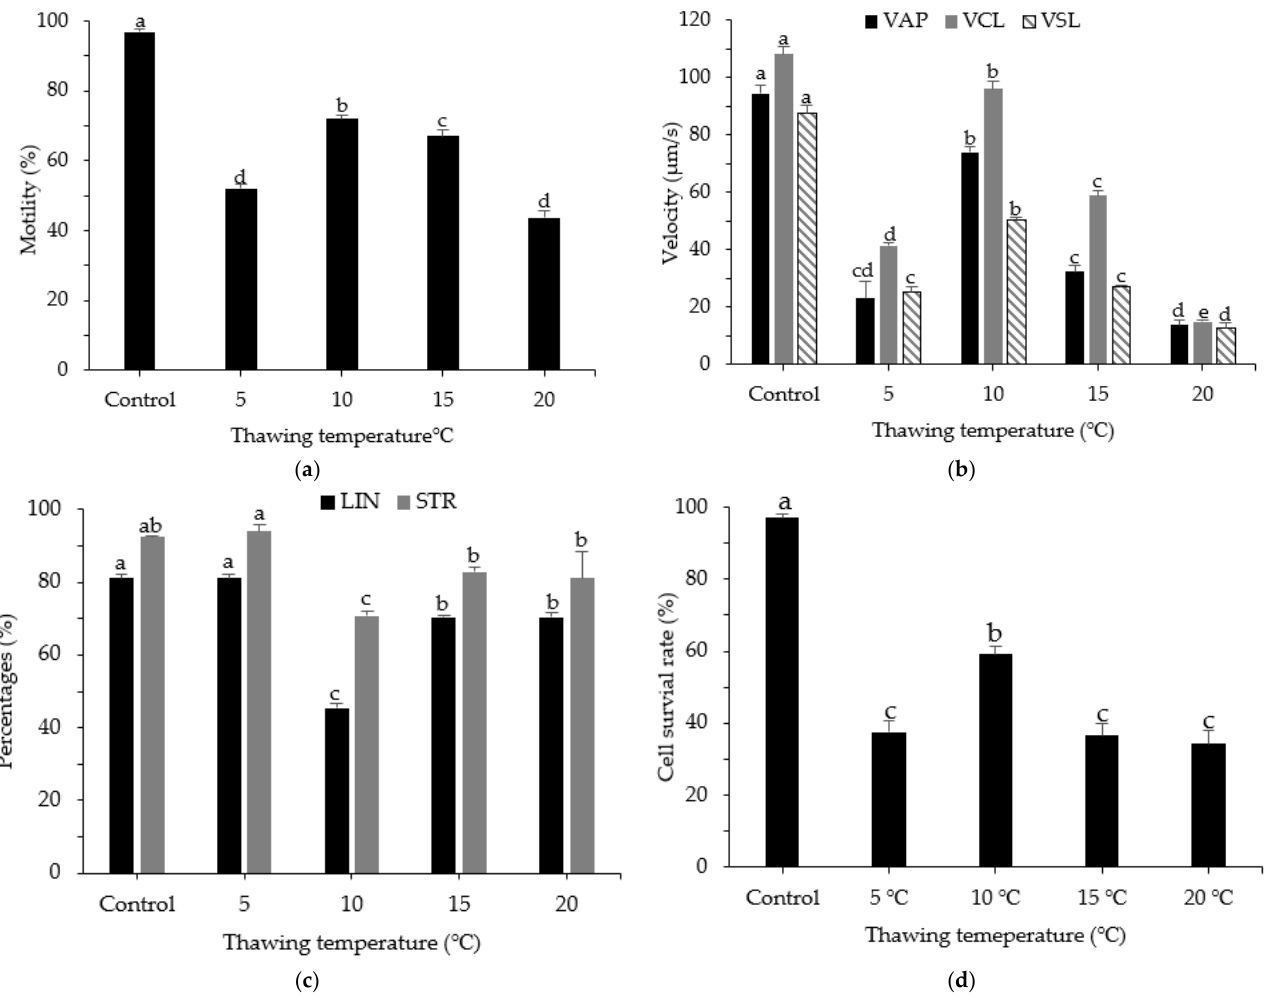
Figure 5. Computer-assisted sperm analysis of frozen and fresh sperm from roughscale sole, Clido- derma asperrimum , using various thawing temperatures. ( a ) Motility (%), ( b ) average path velocity (VAP; μm s −1 ), curvilinear velocity (VCL; μm s −1 ), straight- line velocity (VSL; μm s −1 ), ( c ) linearity (LIN; %), straightness (STR; %), and ( d ) cell survival rate (%). Different lowercase letters indicate significant differences among thawing temperatures ( p < 0.05). Control, fresh sperm.